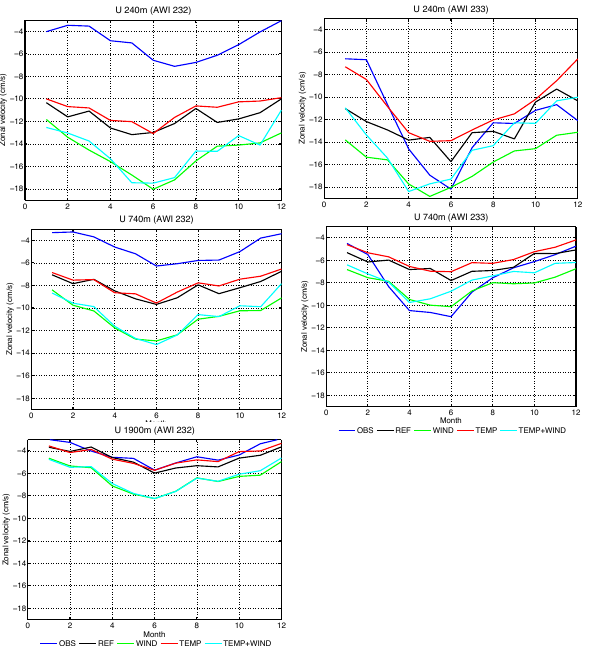
Fig. 9. Comparison of the mean zonal velocity at the AWI 233 and 232 moorings (see Figs. 7 and 8 for positions) simulated for each month and averaged over the period 1985–1989 (black line for REF, green line for WIND, red line for TEMP and cyan line for WIND + TEMP) and with observations over the period 1996–2000 (blue line).